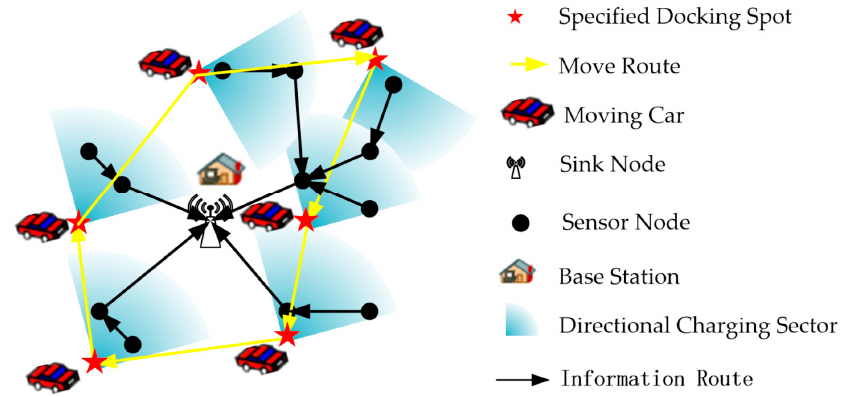
Figure 4. The DVC’s docking spots, charging orientations and moving path.